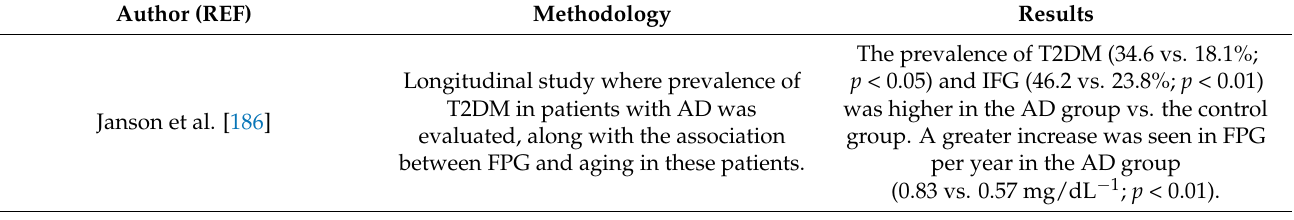
Table 3. Effect of cognitive dysfunction and suffering from MS or MS